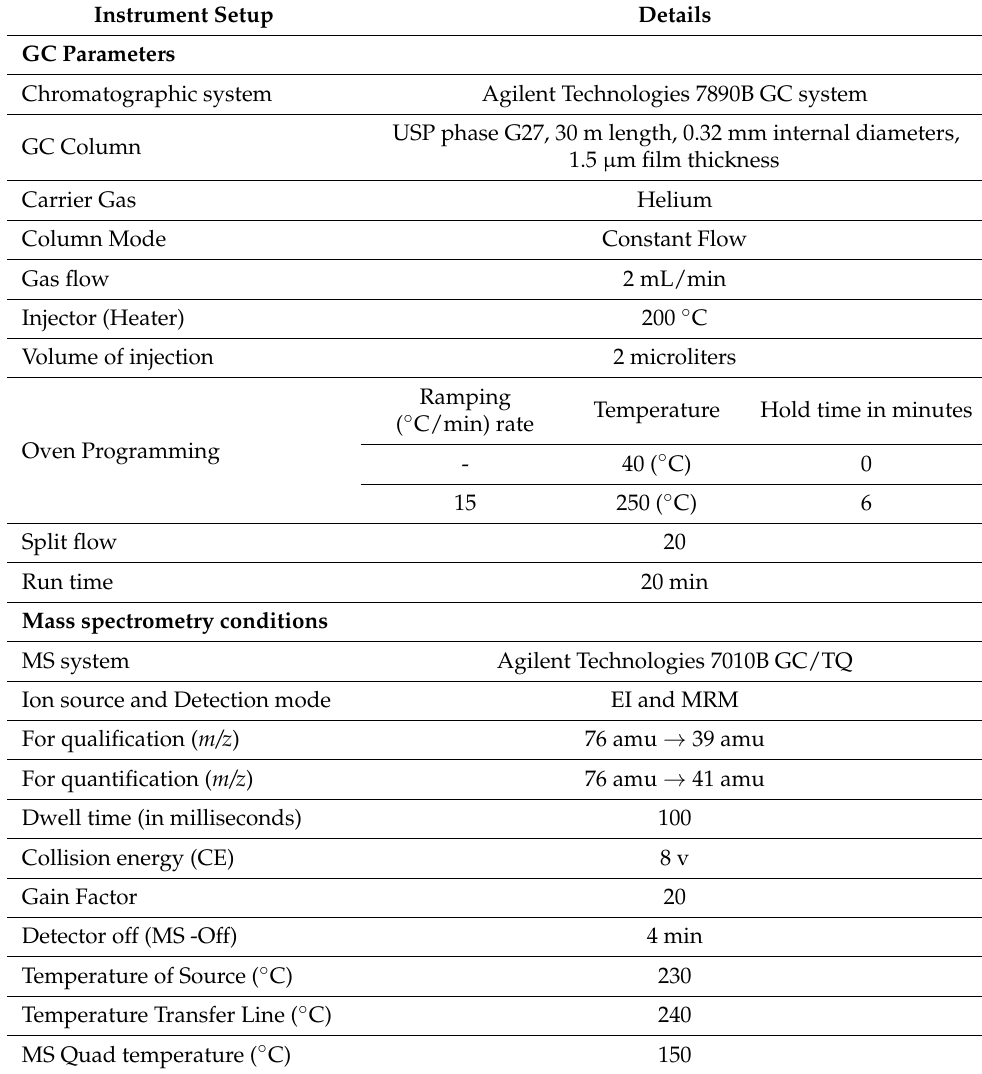
Table 1. GC-MS/MS instrument final